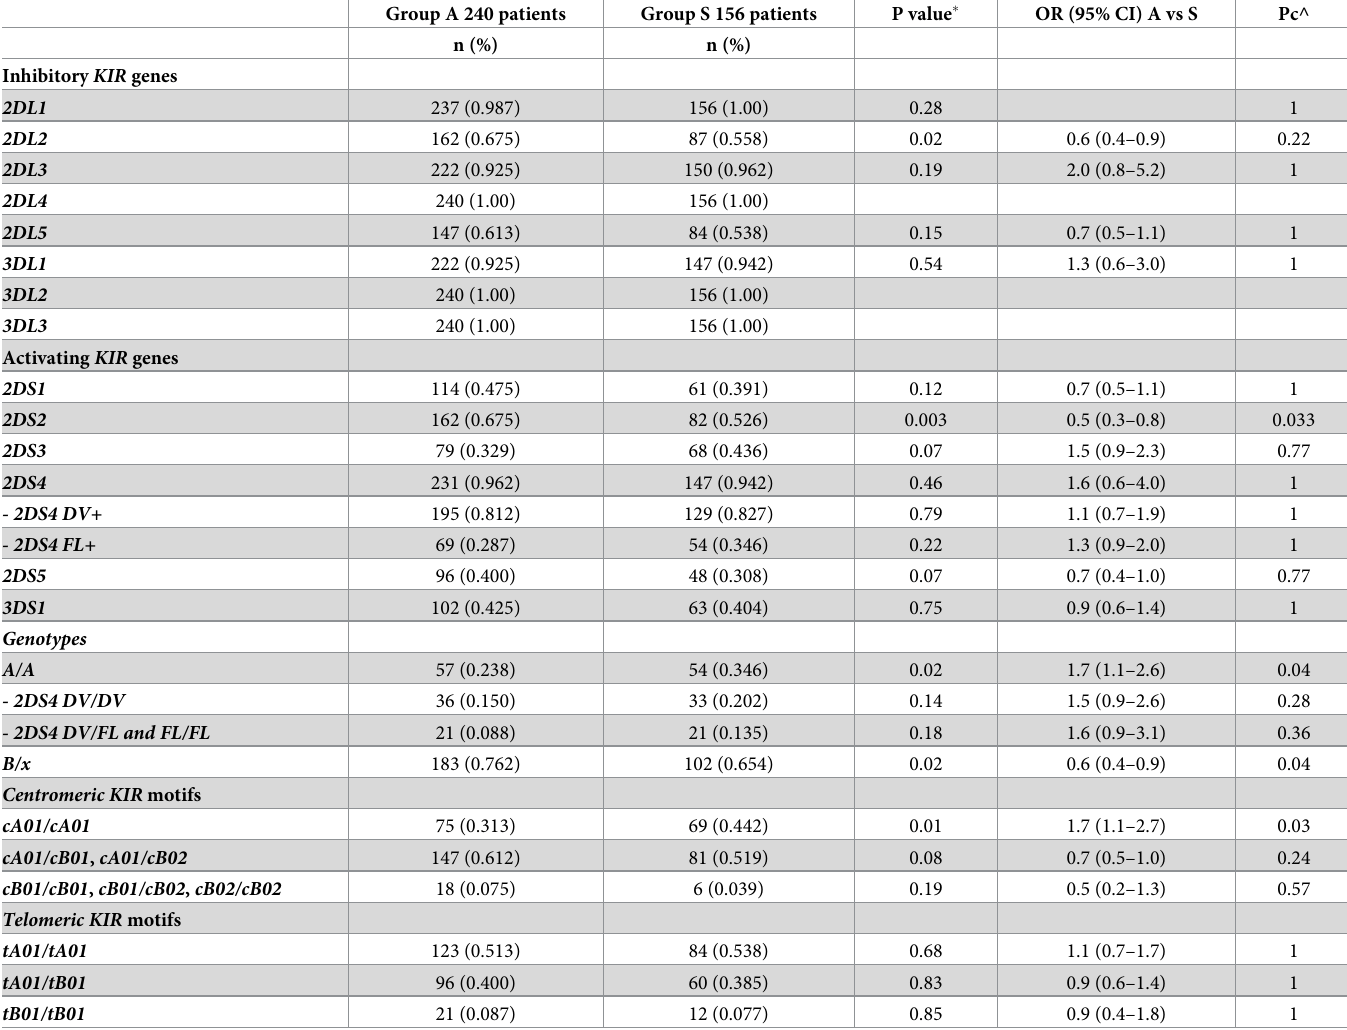
Table 4. KIR genes and genotype frequencies compared between patients divided according to clinical manifestations.